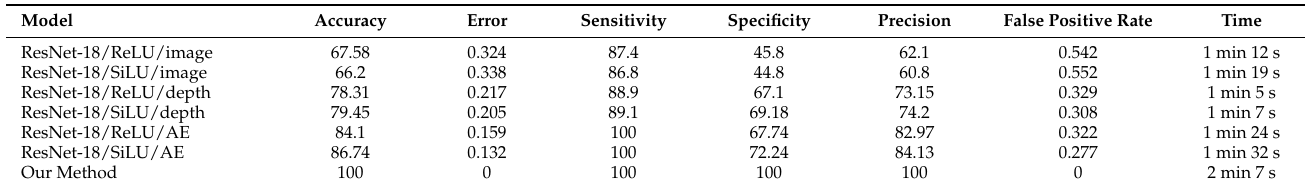
Table 1. Quality metrics of different model